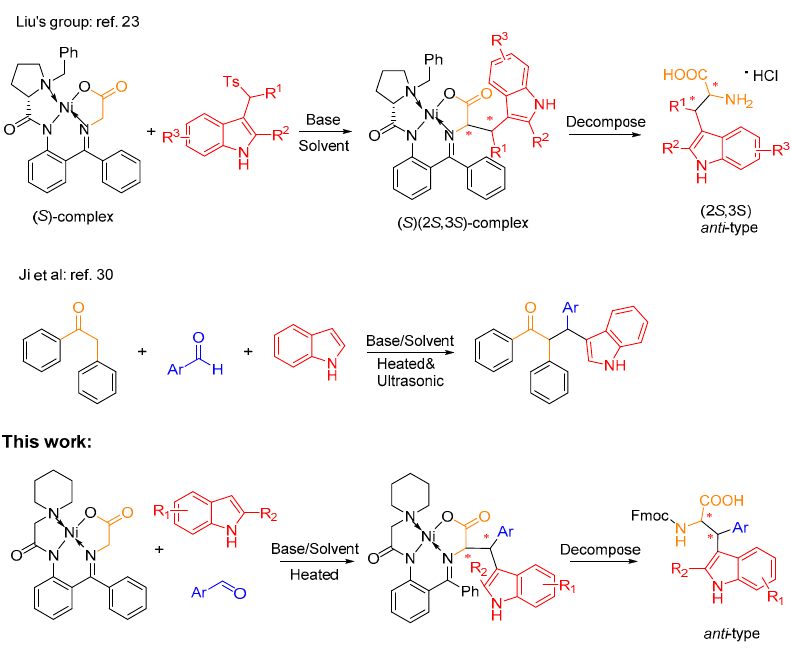
Figure 1. Three-component condensation based on previous works.